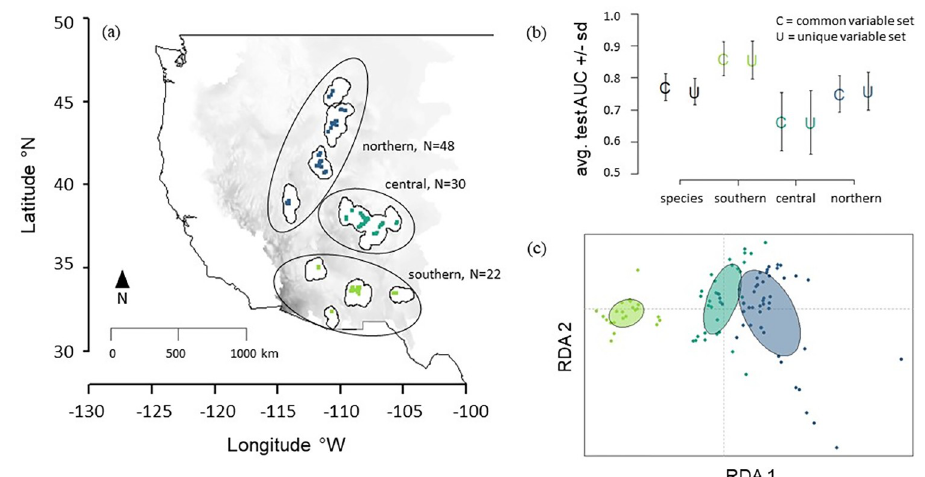
Fig 1. Panel (a) Geographic training extents and occurrence points. Panel (b) Test area under the curve of the receiver-operating characteristic values (AUC) +/- standard error for five cross-validated model replicates. Panel (c) RDA (Redundancy Analysis) plot of environmental variables included in final computational experiments. Geographic training extents are represented in white with corresponding occurrence records separated by color. The northern population is represented in dark blue (N = 48 occurrence records), the central population in teal (N = 30), and the southern population in green (N = 22). The background gradient represents the larger geographic space on which models are projected in the Western United States. In panel (b), color represents geographic training extent of model as in panel (a). Symbol (U or C) represents the variable selection method with “U” = unique predictor variable selection within respective geographic training extents and “C” = a common set of variables provided to all models. Details of “U” and “C” selection can be found in the methods. The background map of the United States represented in this figure was accessed through the R package “maptools” [82]. Maps are projected in WGS84 (World Geodetic System 1984) or EPSG